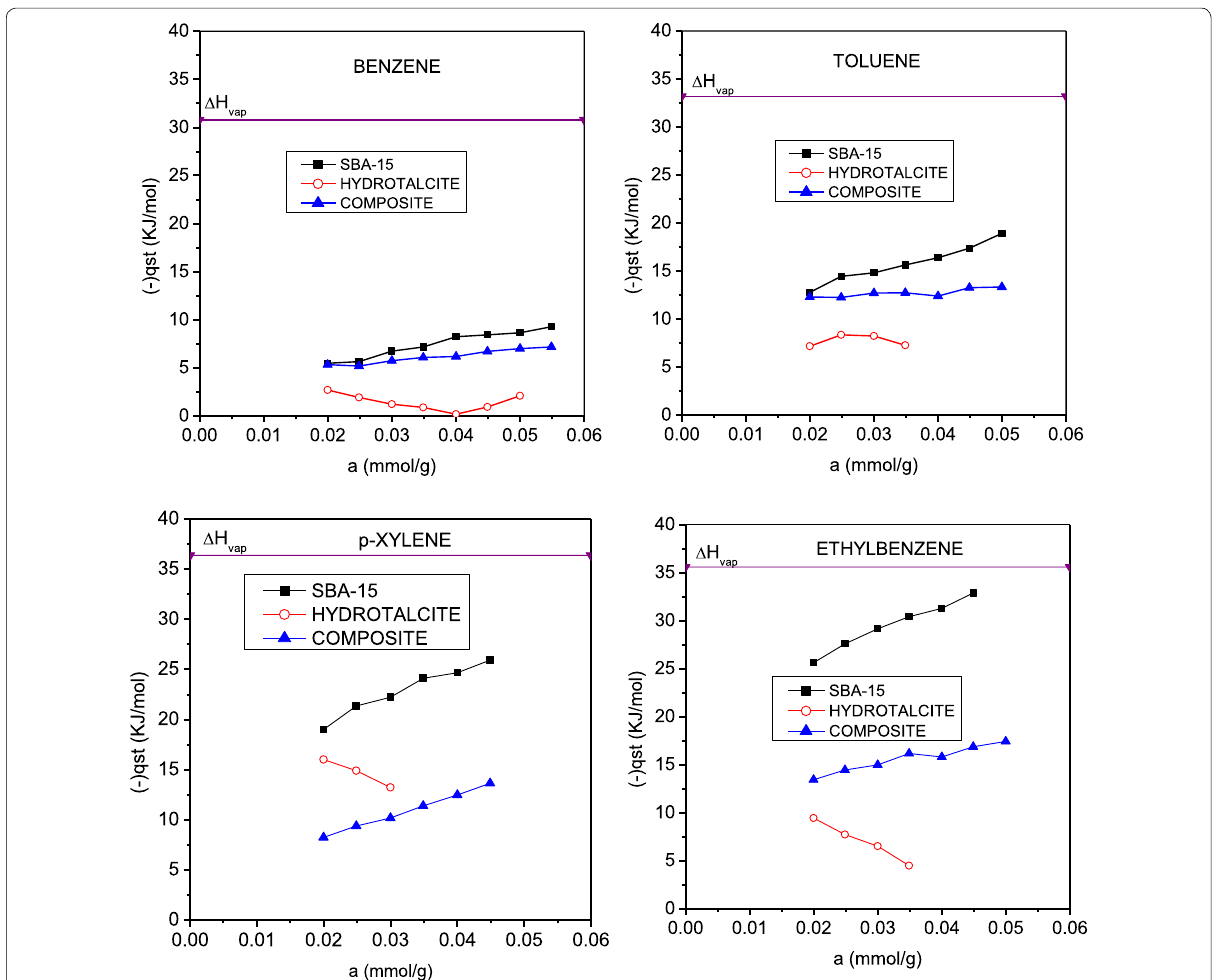
Fig. 12 Isosteric heats of adsorption of benzene, toluene, p ‑xylene, and ethylbenzene for SBA‑15, HT C , and SBA‑15/HT C25 , respectively